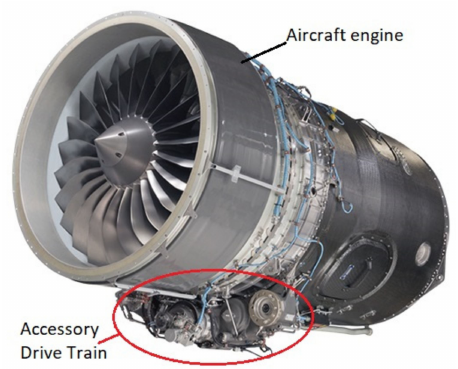
Figure 1. Aircraft engine with accessory gear (ADT).